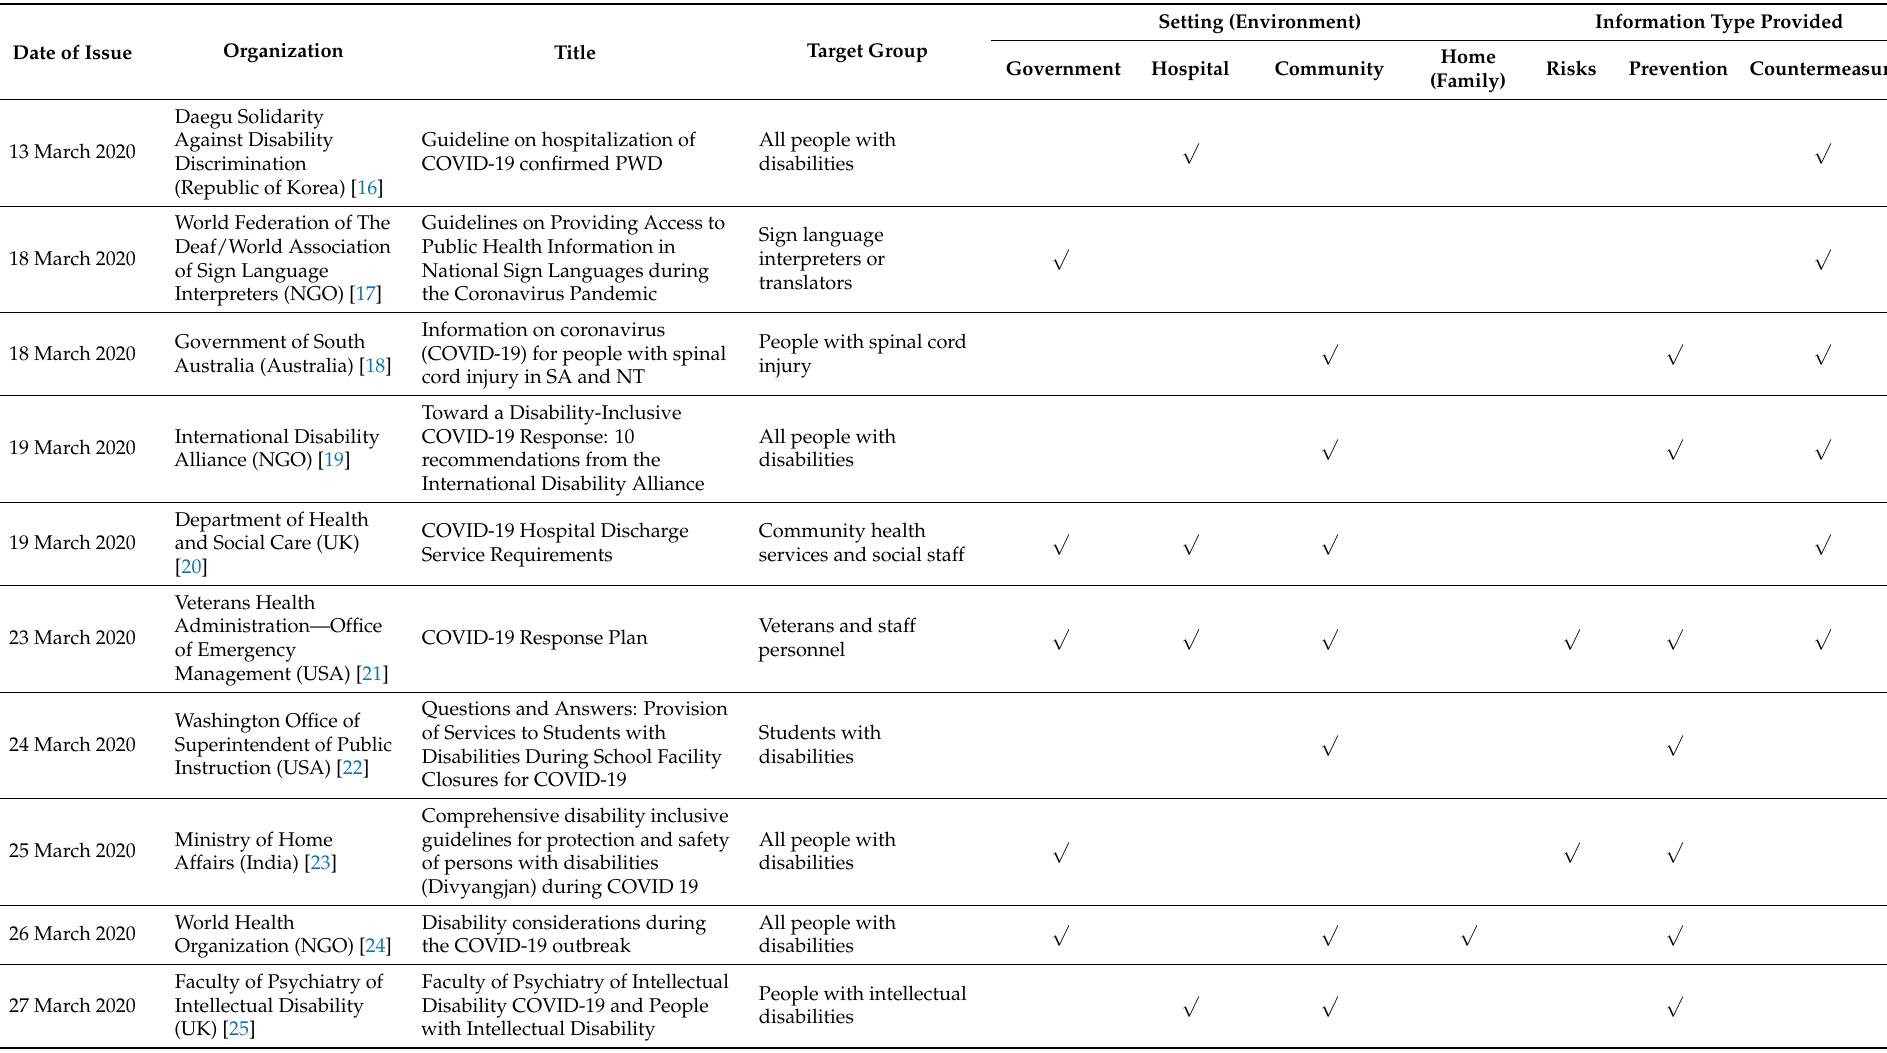
Table 1. Summary: The early phase of COVID-19 pandemic guidelines for people with